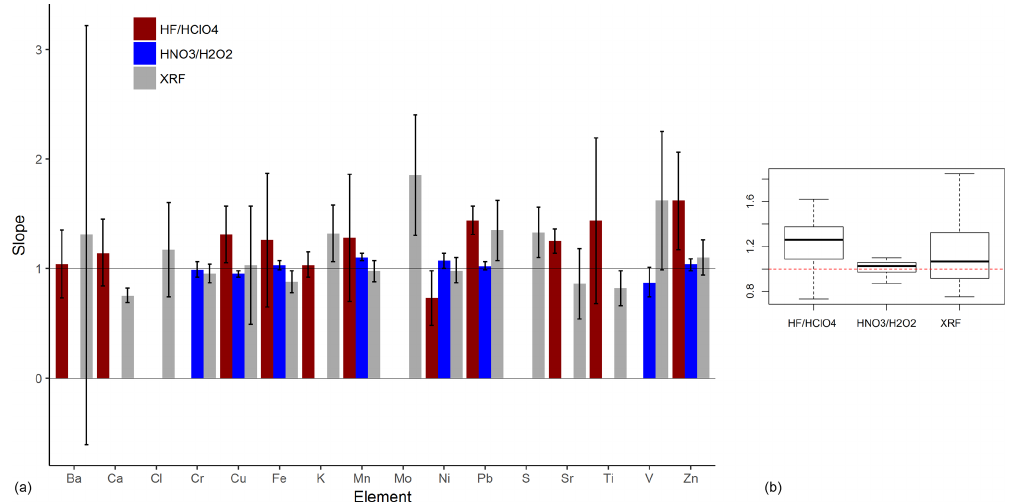
Figure 7. Slope values ( + 95% confidence interval) of Deming regressions (XACT vs. ICP-MS (split in HF / HClO 4 and HNO 3 / H 2 O 2 digestion) and XACT vs. XACT, filter), split by element (a) and corresponding box-and-whisker plots split by method (b)